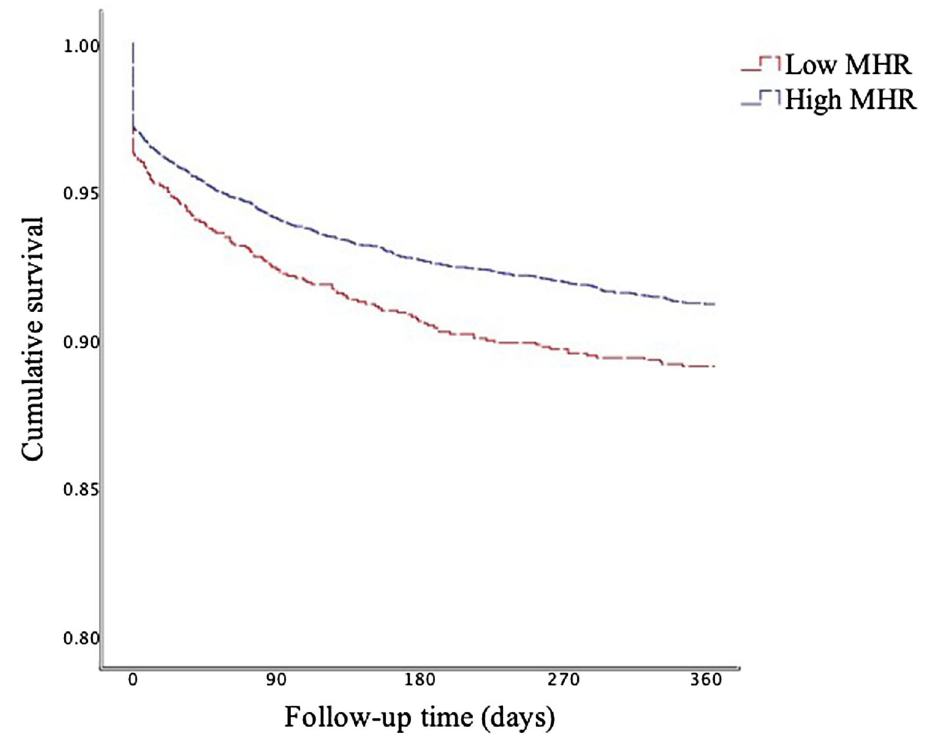
Figure 1. Kaplan–Meier curves of 1-year mortality by